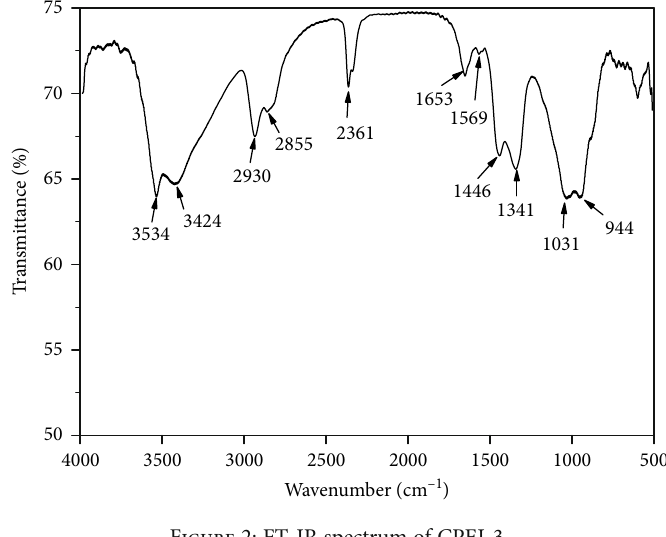
Figure 2: FT-IR spectrum of CPEI-3.